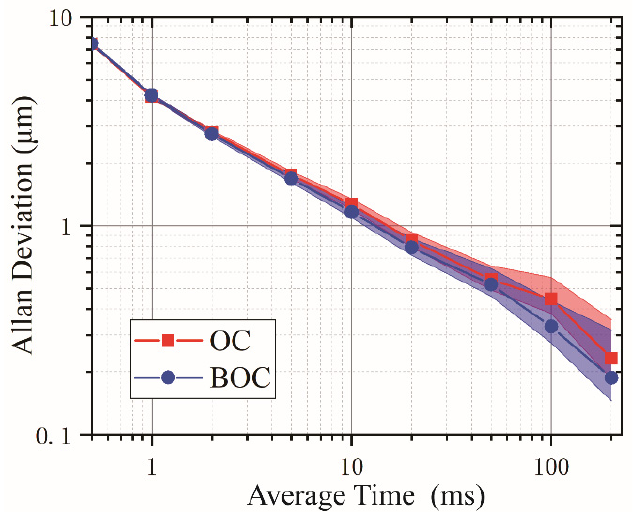
Figure 9. Allan deviation of the measured distance at 0.7-m target-reference separation.